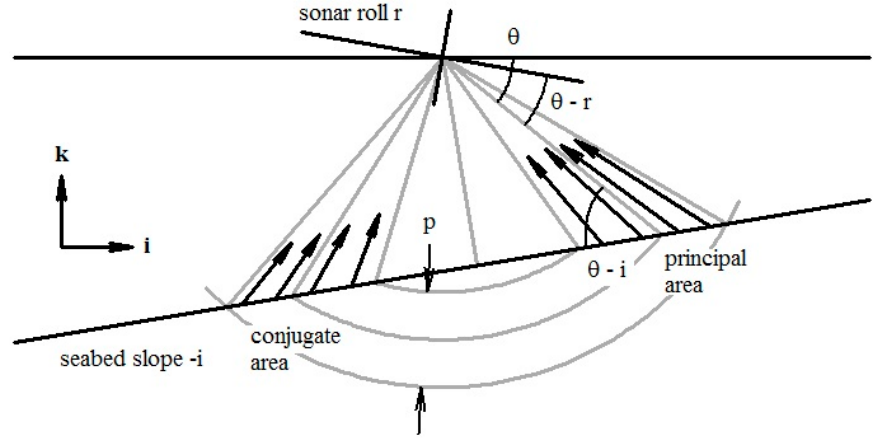
Figure 5. Effective area of the seabed ensonified near normal incidence. The magnitude of the intensity recorded at the sonar is the magnitude of the vector sum of intensity contributions from elemental partial annuli to both sides of the normal at the seabed. Along-trace side view. The direction of the sonar vehicle is into the page.